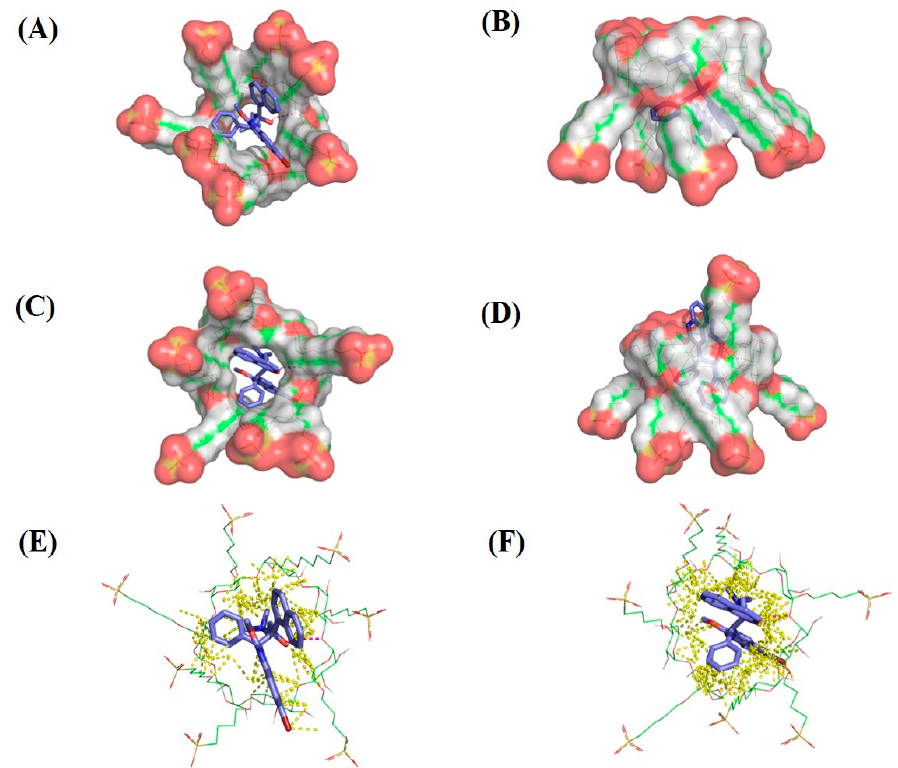
Figure 7. Bedaquiline docked onto the center of ( A , B ) SBE- β -CD-isomer 1 and ( C,D) SBE- β -CD-isomer 2, from the perspective looking onto the top view ( A , C ) and side view ( B , D ). Hydrogen bonds are shown by dashed magenta lines and all non-polar hydrogens are hidden. Surface representations are shown for cyclodextrins. Bedaquiline docked onto the center of ( E ) SBE7 β -CD-isomer 1 and ( F ) SBE7 β -CD-isomer 2, from the perspective looking onto the primary face. Hydrogen bonds are shown by dashed magenta lines, yellow dashed lines show any other contacts within 3 Å radius, and all non-polar hydrogens are hidden.